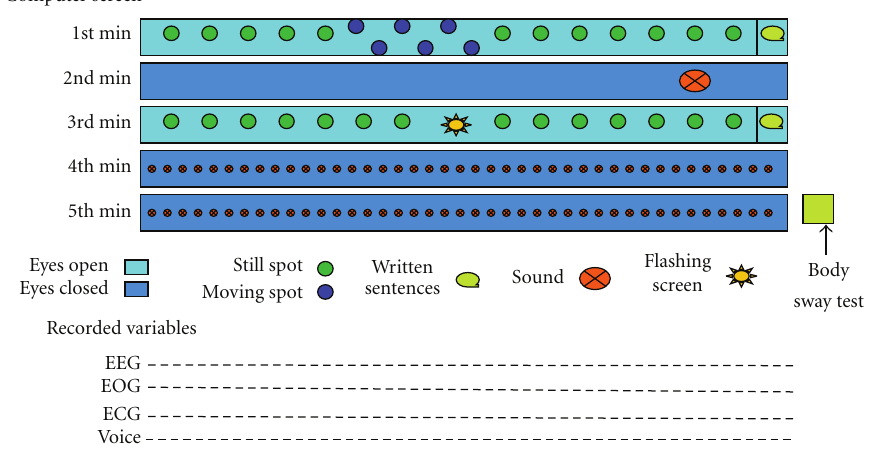
Figure 2: Stimulations protocol for physiology data